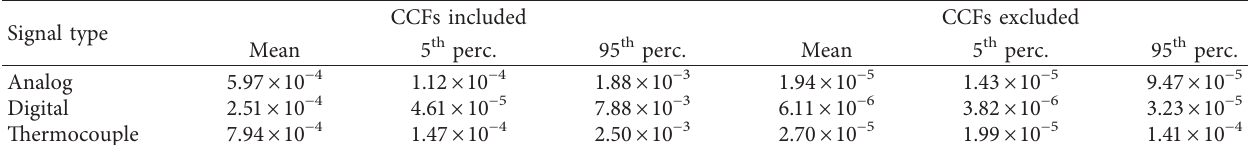
Table 4: Calculation results for Top Event RT 1IN ST